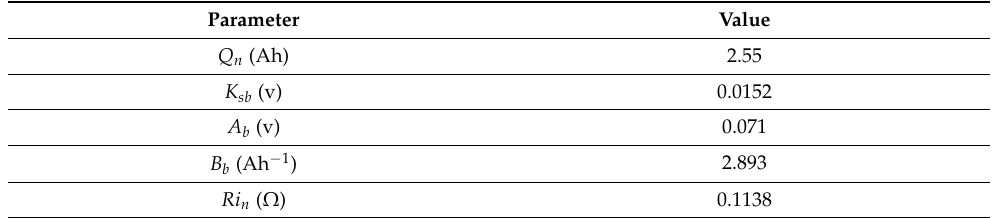
Table 6. Panasonic Lithium-ion CGR18650E battery cell